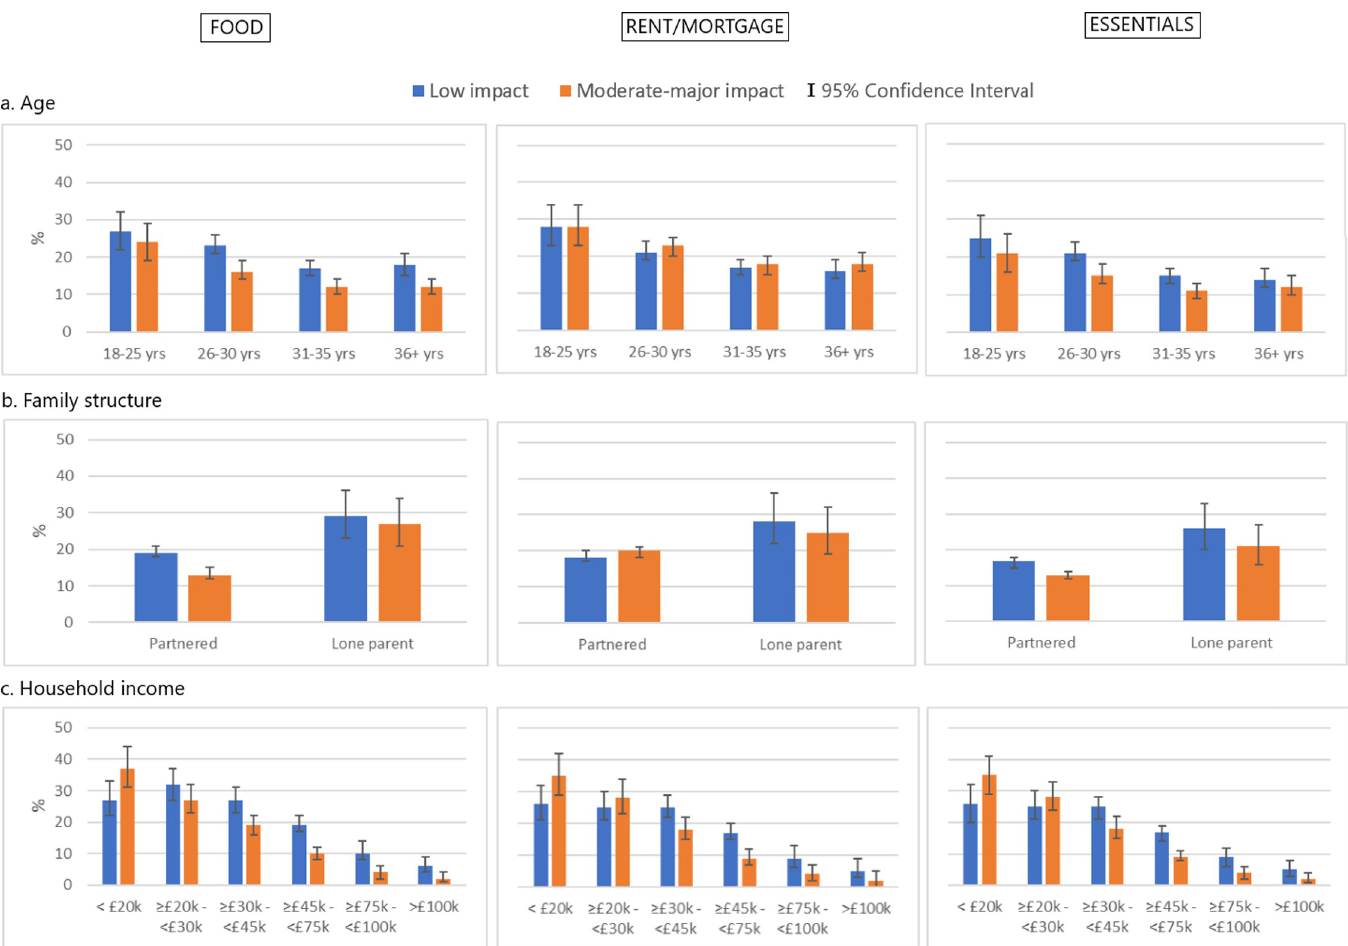
Fig 1. Impact of the COVID-19 pandemic on household ability to cover food, rent/mortgage, and essentials expenses by maternal socio-demographic characteristics in the COVID-19 New Mum Study;